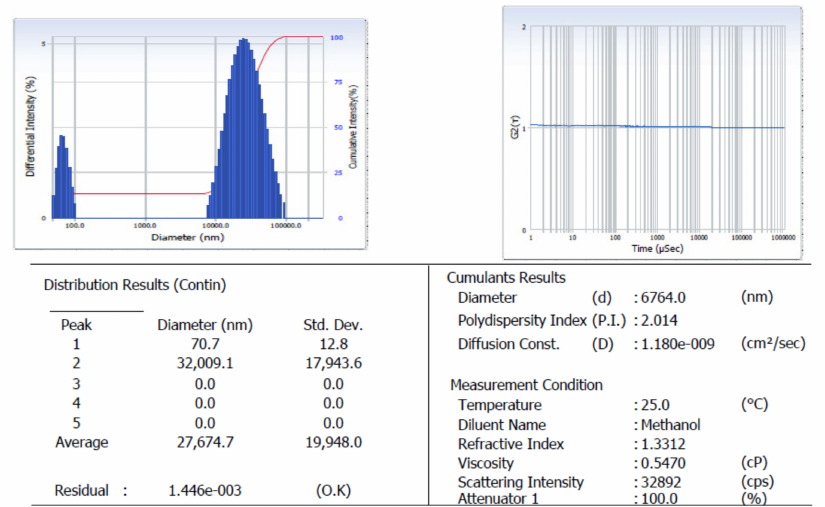
Figure 4. Particle size distribution of Cu(II)-AEA NPs.